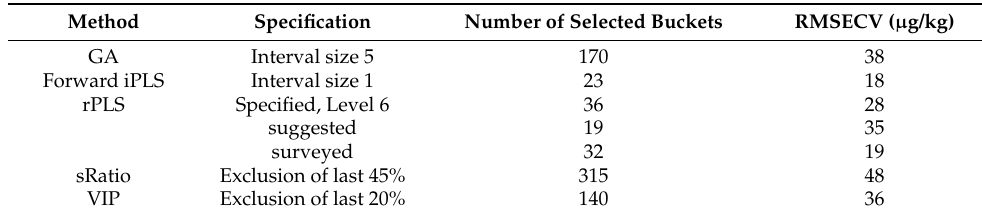
Table 1. Comparison of variable selections based on PLS regression of mean-centered y-data and standardized x-data with six PLS components, PLS toolbox.